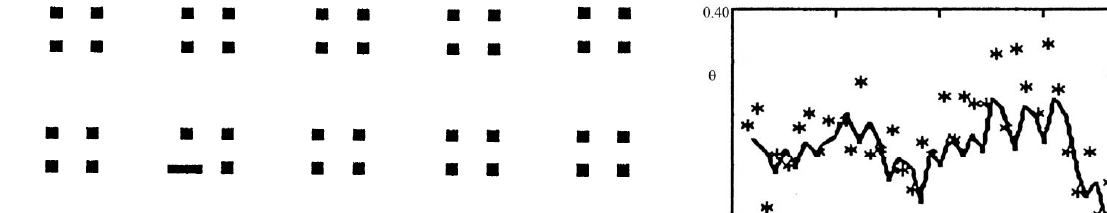
Fig. 10. Schematic representation of cross correlation matrices of estimated residues: ( (cid:4) ) auto-cross correlations non significantly different from zero, ( – ) auto-cross correlation significantly greater than zero.